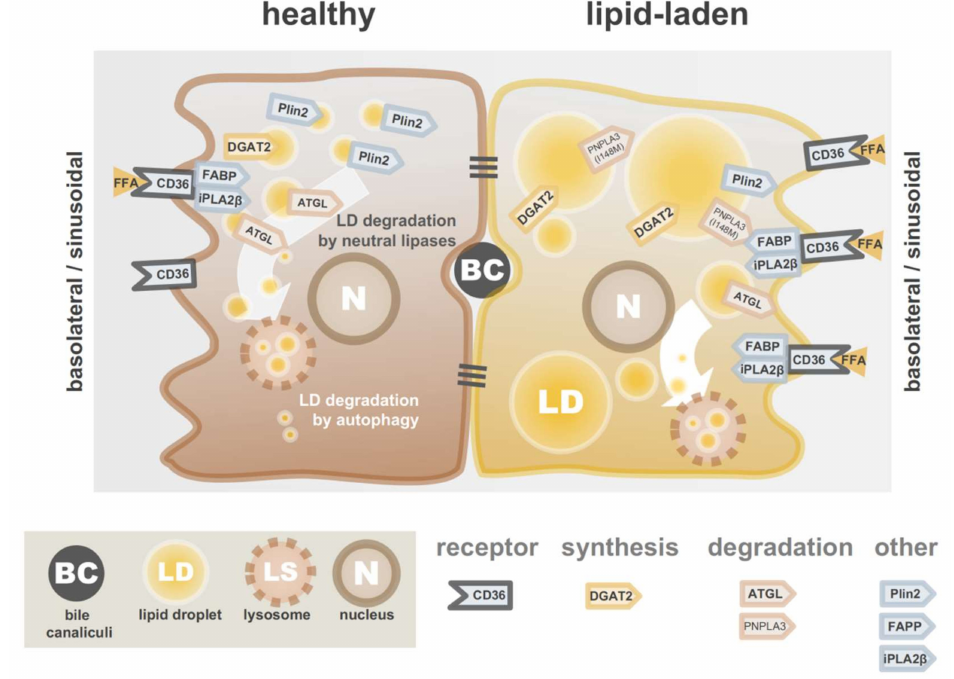
Figure 2. Lipid droplet dynamics in hepatocytes. Cartoon of healthy ( left ) and lipid-laden ( right ) hepatocytes showing key players in LD synthesis, stabilization and degradation. ATGL, adipose triglyceride lipase; BC, bile canaliculi; DGAT2, diacylglycerol acyltransferase 2; FABP, FA-binding protein; iPLA2 β , calcium-independent membrane phospholipase A2; LDs, lipid droplets; LS, lysosome; N, nucleus; PLIN2, perilipin 2; PNLPLA3, Patatin-like phospholipase domain-containing protein